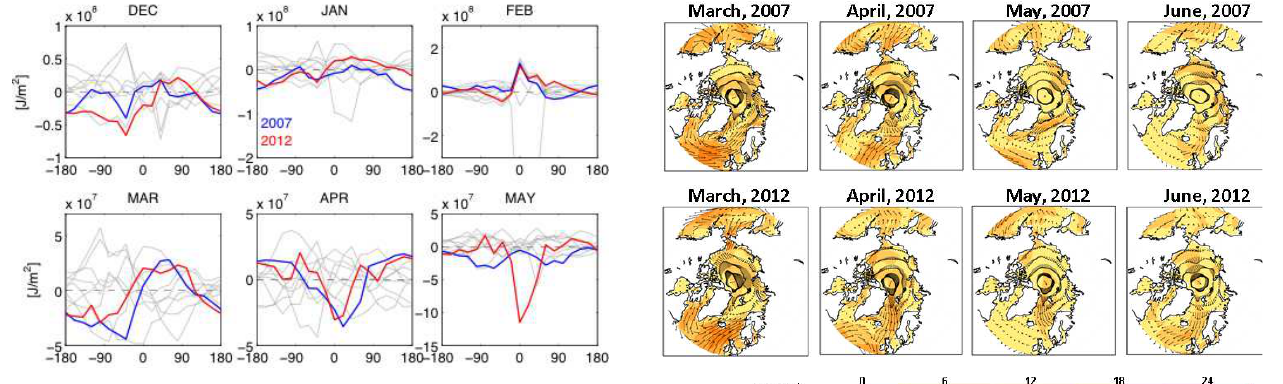
Fig. 7. Meridional means of mass-weighed vertically-integrated Fig. 7: Meridional means of mass-weighed vertically-integrated MSE [J m-2] monthly MSE [Jm − 2 ] monthly anomalies for the latitude band of 65–85 ◦ N. anomalies for the latitude band 65-85N. Monthly anomalies are estimated relative to the 2003-2012 monthly averaged vertical integrals of MSE at each AIRS grid point between Monthly anomalies are estimated relative to the 2003–2012 monthly 65-85N. Merdional averages are shown for 20 degree bins. Gray lines are all months averaged vertical integrals of MSE at each AIRS grid point between (DJFMAM) for 2003-2012, with 2007 and 2012 highlighted in blue and red, respectively. 65–85 ◦ N. Meridional averages are shown for 20 ◦ bins. Grey lines are all months (DJFMAM) for 2003–2012, with 2007 and 2012 highlighted in blue and red, respectively.